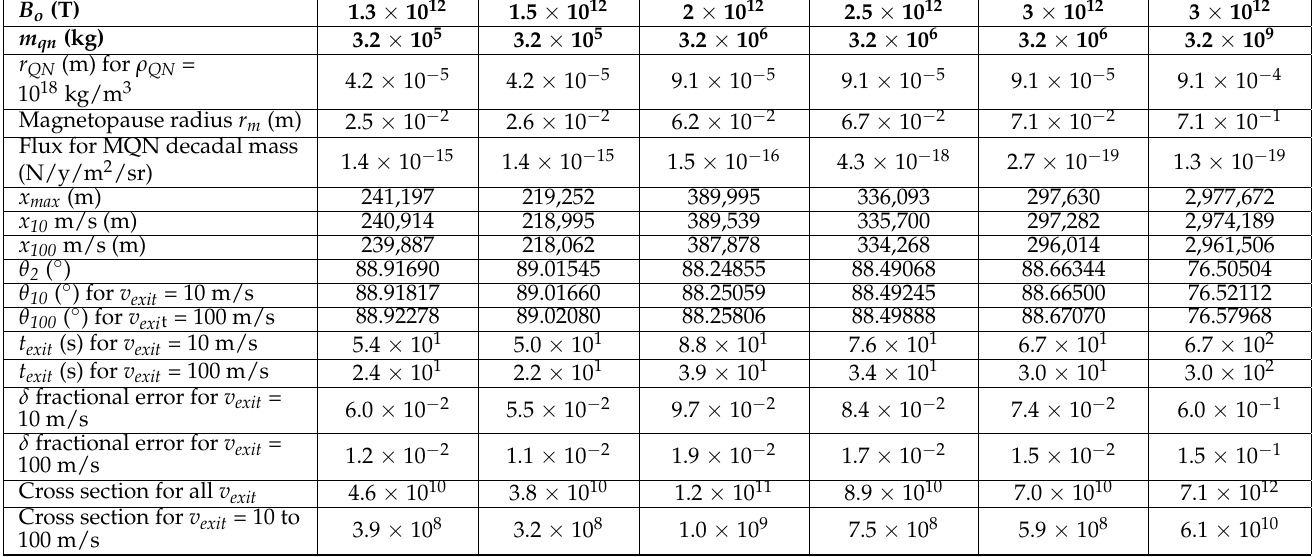
Table A1. Representative examples are given for MQNs with impact velocity of 250 km/s transiting through water as a function of B o and MQN mass m qn .